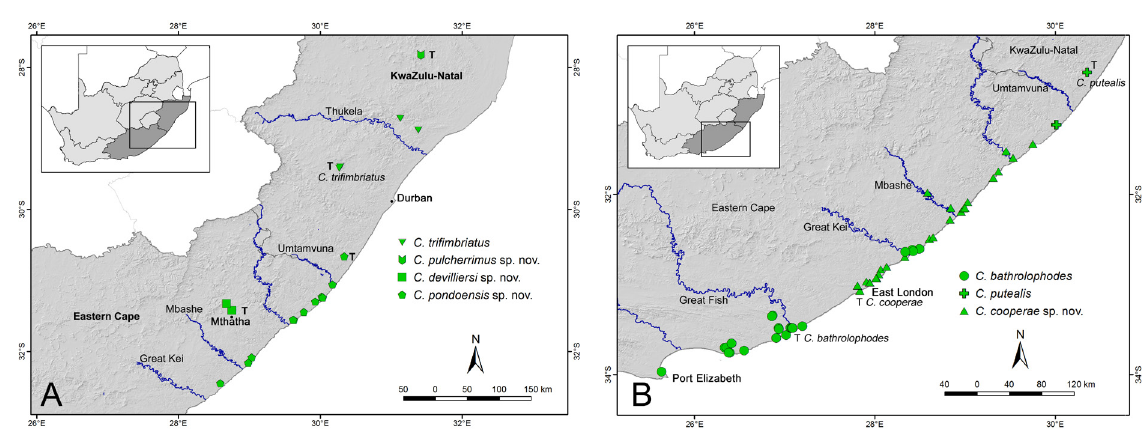
Fig. 16. Distribution map of Chondrocyclus species in the Eastern clade. A . Species in KwaZulu-Natal and the eastern half of the Eastern Cape, on the coast and extending inland. B . Species on the Eastern Cape coast. Note that the range of C. pondoensis sp. nov. overlaps with that of C. putealis Connolly, 1939 and C. cooperae sp. nov. T indicates type localities. Major cities and rivers